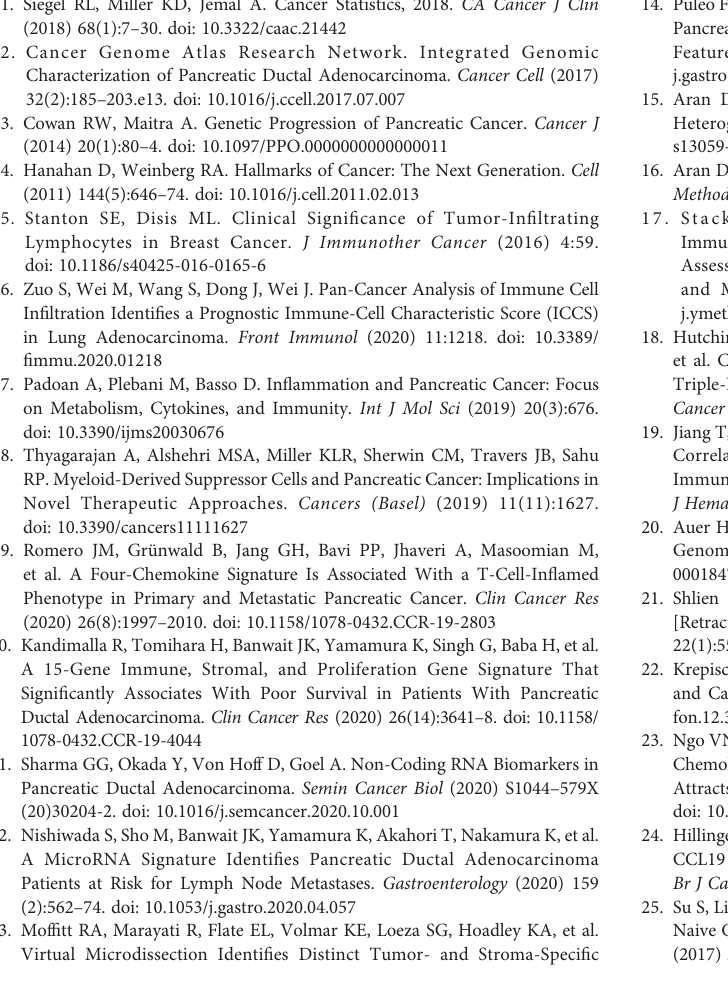
Supplementary Figure S4 | The relation between risk-score and chemokine (A), co-stimulatory factor (B) , co-inhibitory factor (C) in the TCGA PDAC dataset. (A) Box plot for analysis chemokine (CCL2, CCL3, CCL4, CCL5, CCL8, CCL18, CCL19, CCL21, CXCL9, CXCL10, CXCL11 and CXCL13) expression difference in high risk-score vs . low risk-score, respectively. (B) Box plot todepict co-stimulatory factor (CD28, CD27, CD27LG, CD40, CD40LG, ICOS, ICOSLG, TNFSF4, TNFRSF4, TNFSF9, TNFRSF9, TNFSF18 and TNFRSF18) expression difference in high risk-score vs . low risk-score, respectively. (B) Box plot toillustrate co-inhibitory factor (CTLA4, PDCD1LG1, PDCD1LG2, PDCD1, VSIR, LAG3, LAGLS9, HAVCR2, DIDO1 and TIGIT) expression difference in high risk-score vs . low risk-score, respectively. ns, no statistical signi fi cance. Supplementary Figure S5 | Differential CNV function annotation and prediction by GSEA enrichment analysis in TCGA PDAC dataset. (A) Bar chart showing the top 10 CC-GO terms of differential CNV for high risk-score vs . low risk-score. (B, C) GSEA-based GO analysis-enrichment plots of representative gene sets: axon part, neuron projection enrichment in low risk-score, respectively. (D) GSEA-based KEGG-enrichment plots of representative gene sets from activated pathway: neurotrohin signaling pathway in low risk-score. In the GSEA plots, the vertical axis represents enrichment score. The enrichment score increased with the number of enriched genes and vice versa. CNV, copy-number variation; GSEA, Gene Set Enrichment Analysis; ES, enrichment score; NES, normalized enrichment score; GO, Gene Ontology; CC, Cellular Component; KEGG, Kyoto Encyclopedia of Genes and